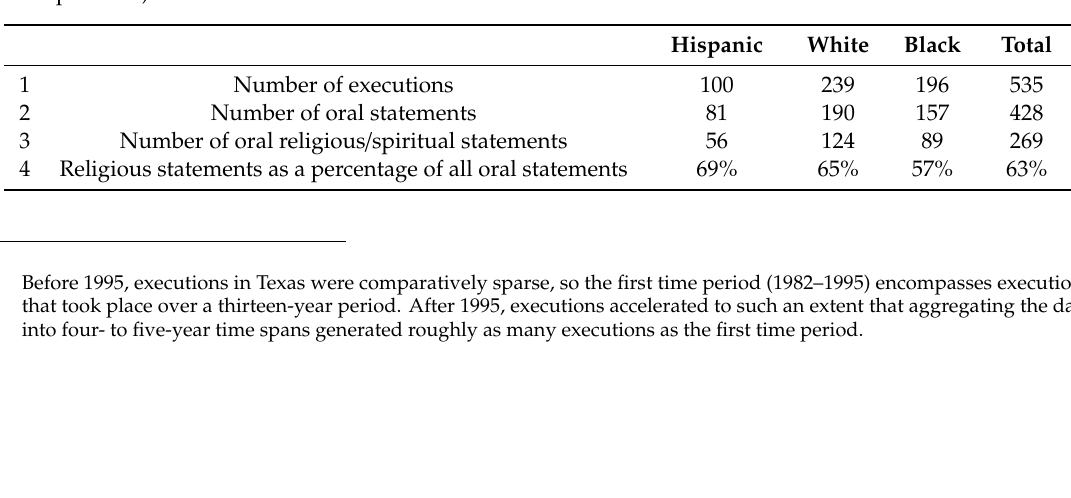
Table 1. Number of Executions and Religious Statements by Race and Ethnicity (7 December 1982–6 April